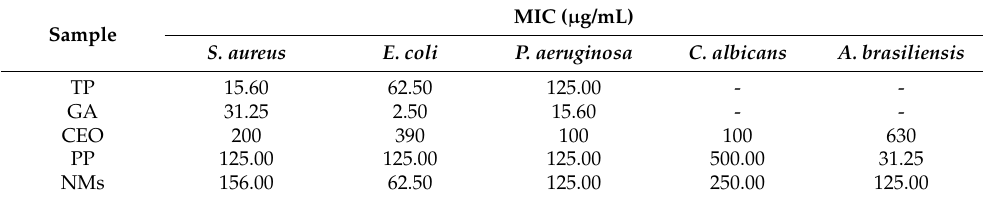
Table 1. The minimum inhibitory concentration value of each active antimicrobial